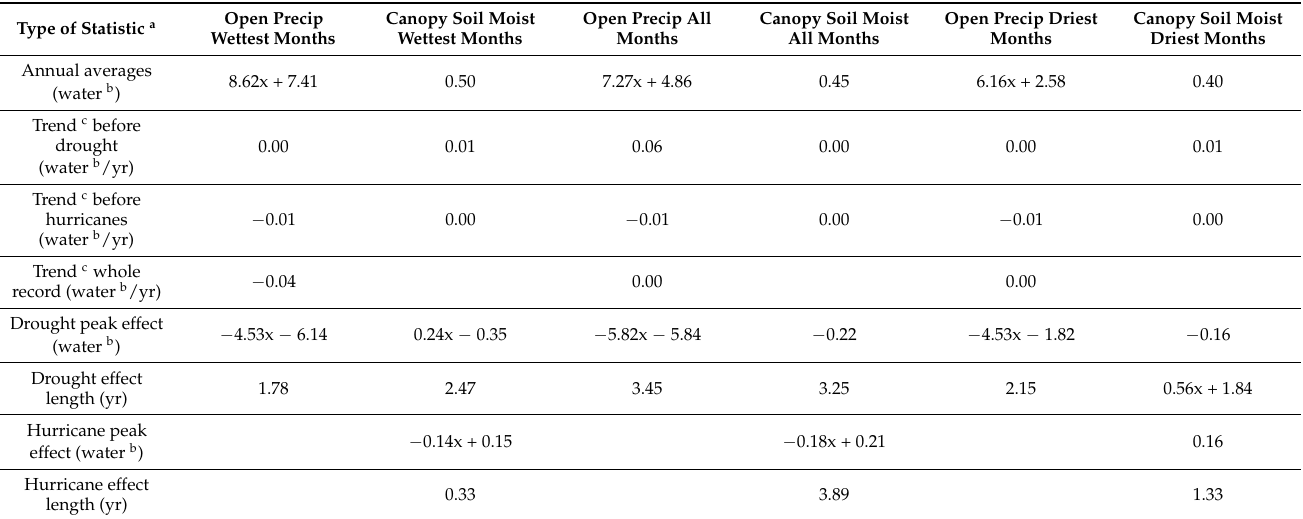
Figure 6. Average of the statistical calculations on the under-canopy soil moisture for wettest months, all months, and driest months. Plot ( a ) shows the site period of record average values as points with the trend lines of magnitude with elevation. Plot ( b ) shows the periodic component timeseries (“all months” have period 1-month and “wettest” and “driest” have period 4-months) averaged over the sites as thick lines, with thin dashed trend lines of magnitude with time at the average site elevation (576 m). The colors signify the same variable across the plots. Only the longest trend calculated is shown, from the pre-hurricane data. The estimated event-affected (drought then hurricane) periods are shown in thick bars on the bottom of plot with the gray part of the bars as the 90% confidence intervals around the end points. Table 3. Region-Wide Linear Least Squares Relationships of Precipitation and Soil Moisture with Elevation (x, in km).